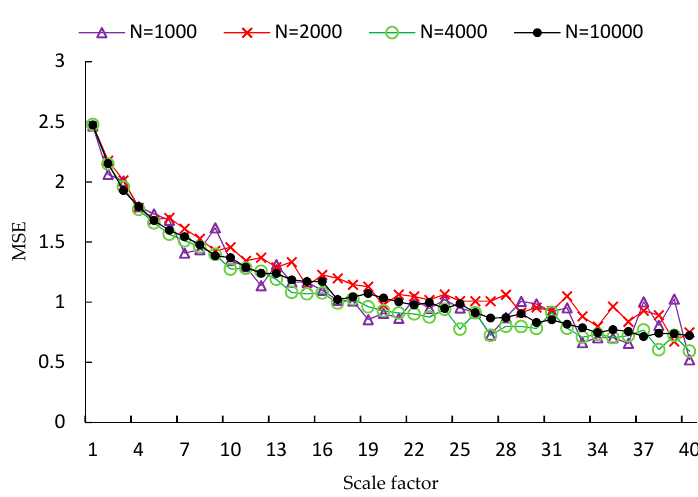
Figure 2. MSE values for white noise signals with different lengths.